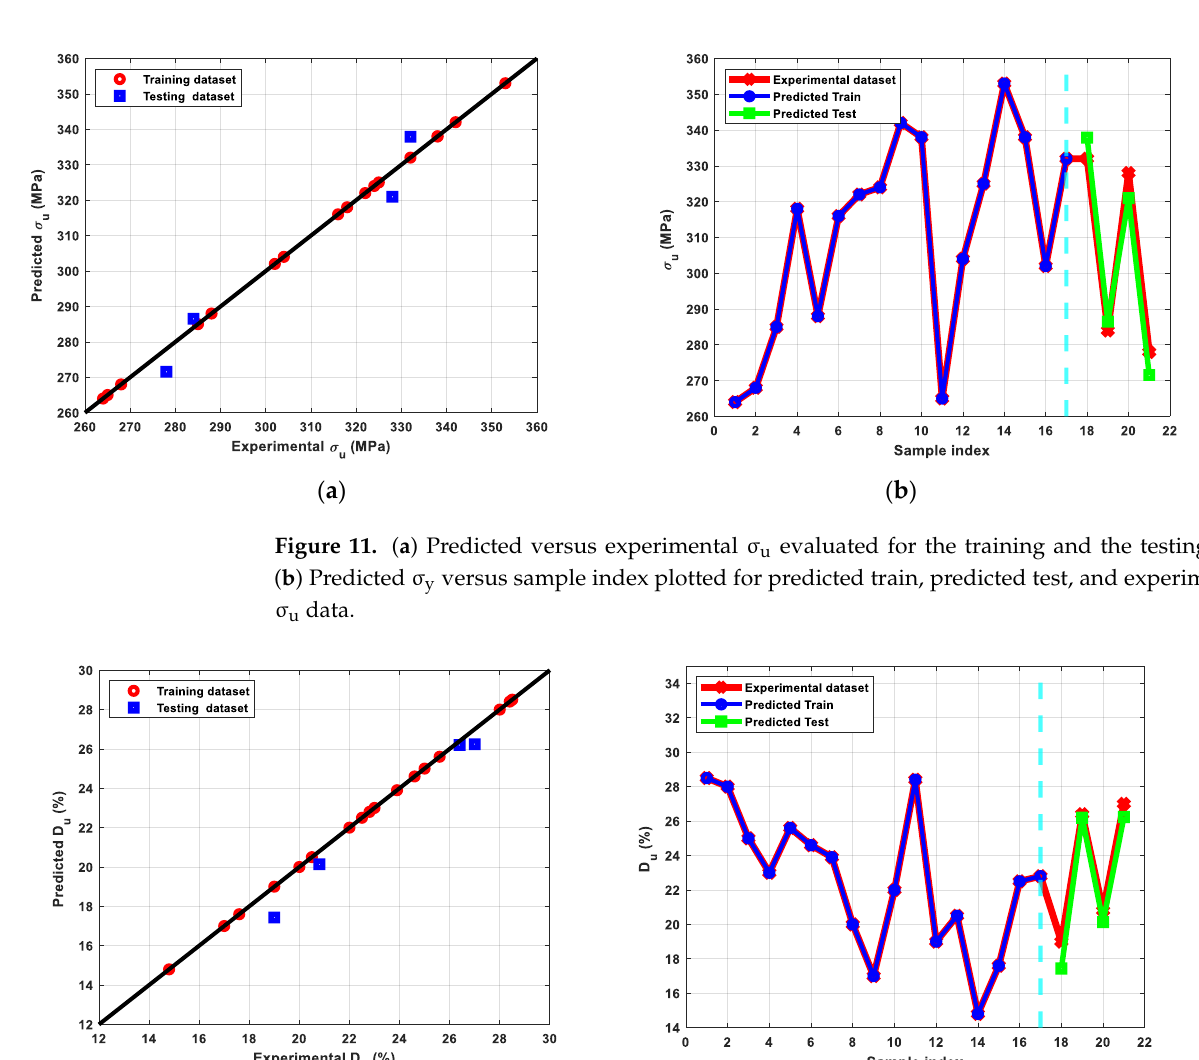
Figure 10. ( a ) Predicted versus experimental σ y evaluated for the training and the testing sets, ( b ) Predicted σ y versus sample index plotted for predicted train, predicted test, and experimental σ y datasets.